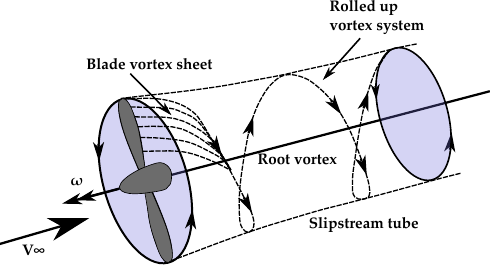
Figure 1. Vortex system and slipstream tube behind a